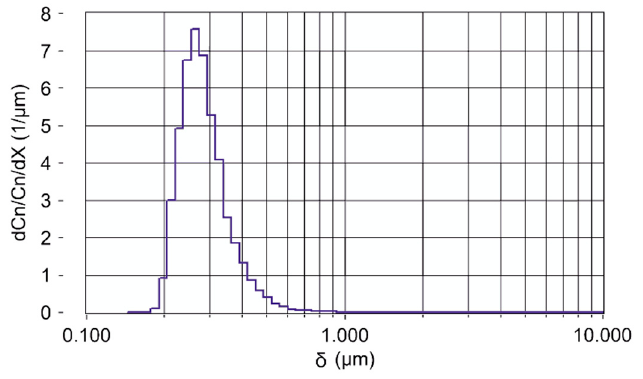
Figure 1. Experimental set-up of the dummy visualizing emitted aerosols by blue light illumination.